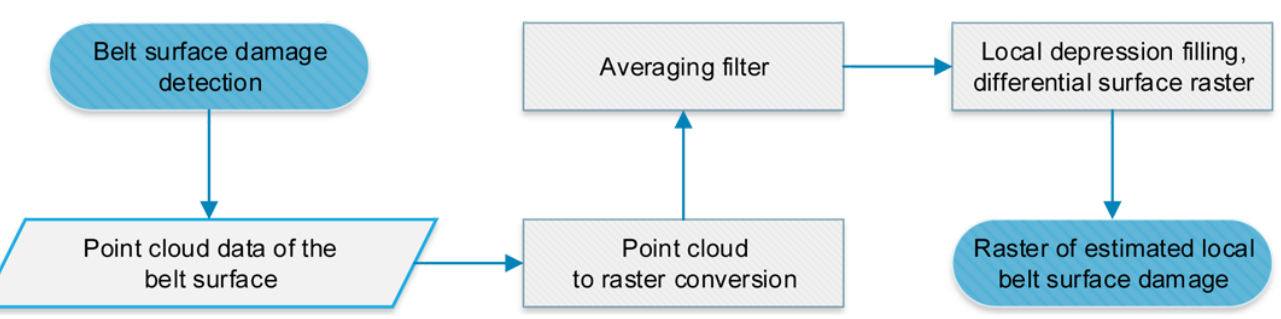
Figure 4. Workflow of belt surface local irregularities